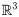
Data used for line fitting example in R3.The red line is the linear fit determined by minimizing E = (ExEyEz)1/3.